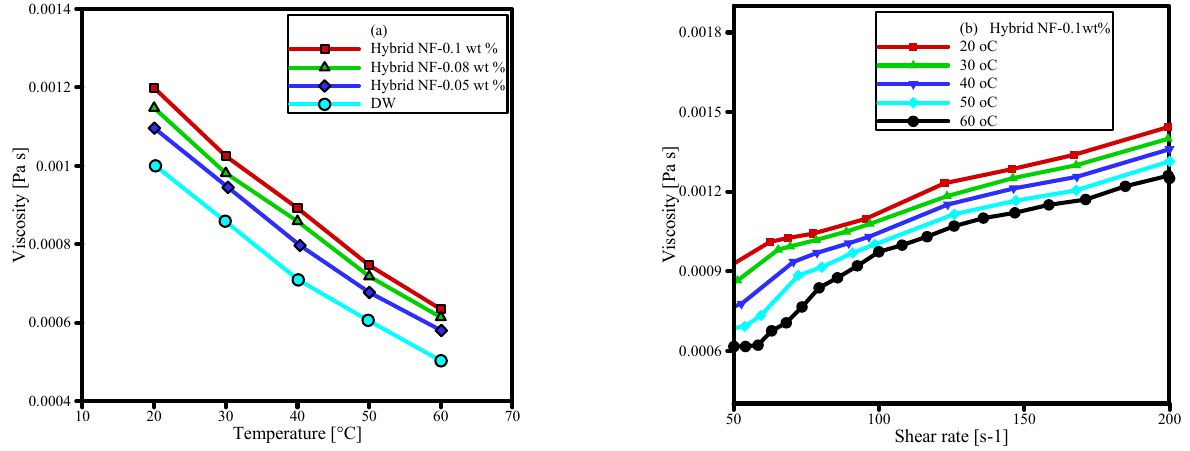
Figure 8. ( a ) Effect of the dynamic viscosity for different temperatures at various weight concentrations. ( b ) Shear rate effect on the dynamic viscosity at different temperatures of water-based hBN/CF-CNTs nanofluid.